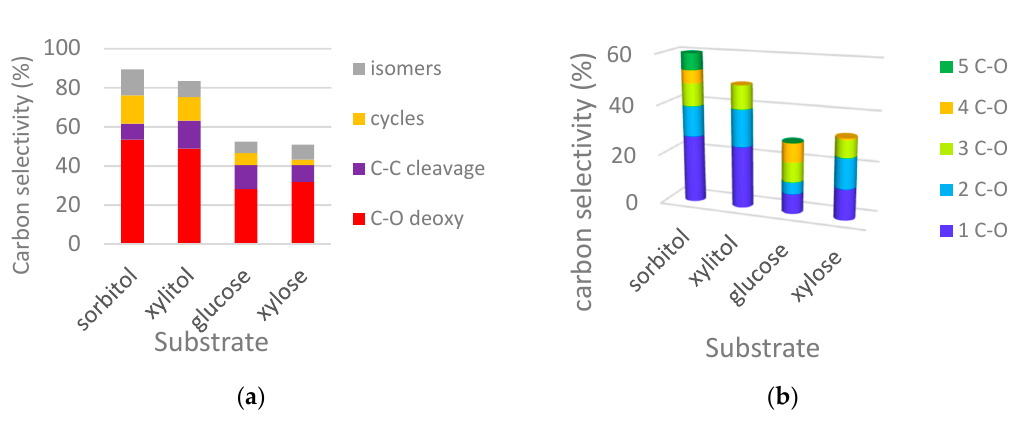
Figure 3. Hydrogenolysis of polyols and sugars over ReO x -Rh/ZrO 2 at ca. 20% sorbitol or xylitol remaining to be converted: ( a ) carbon selectivity to families of products and ( b ) selectivity to C-O bond sub-families, 200 °C under 80 bar H 2 .